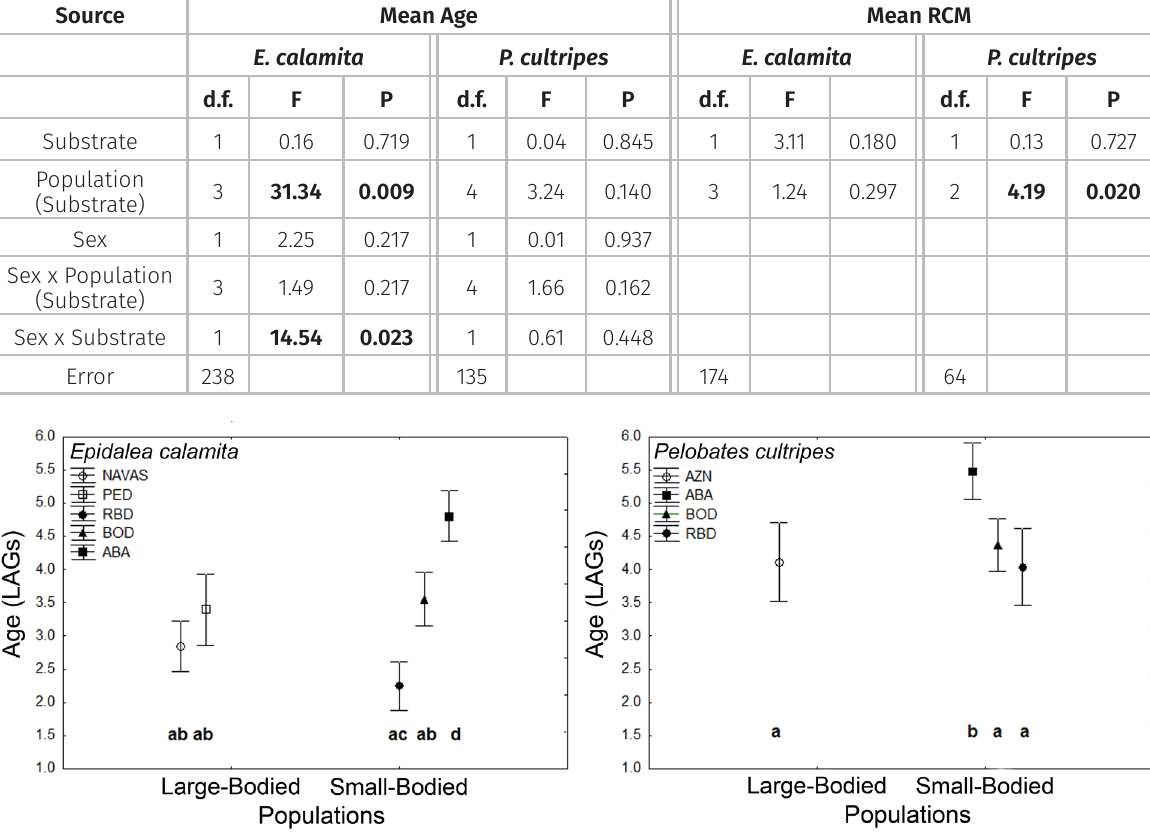
Figure 3. Mean age variations among populations of Epidalea calamita and Pelobates cultripes . Values for both sexes are pooled. Open = Large-Bodied populations , solid = Small-Bodied populations. All values are means ± 1 SE. Different letters mean significant differences using a Scheffe´ post hoc multiple comparison test at α = 0.05.